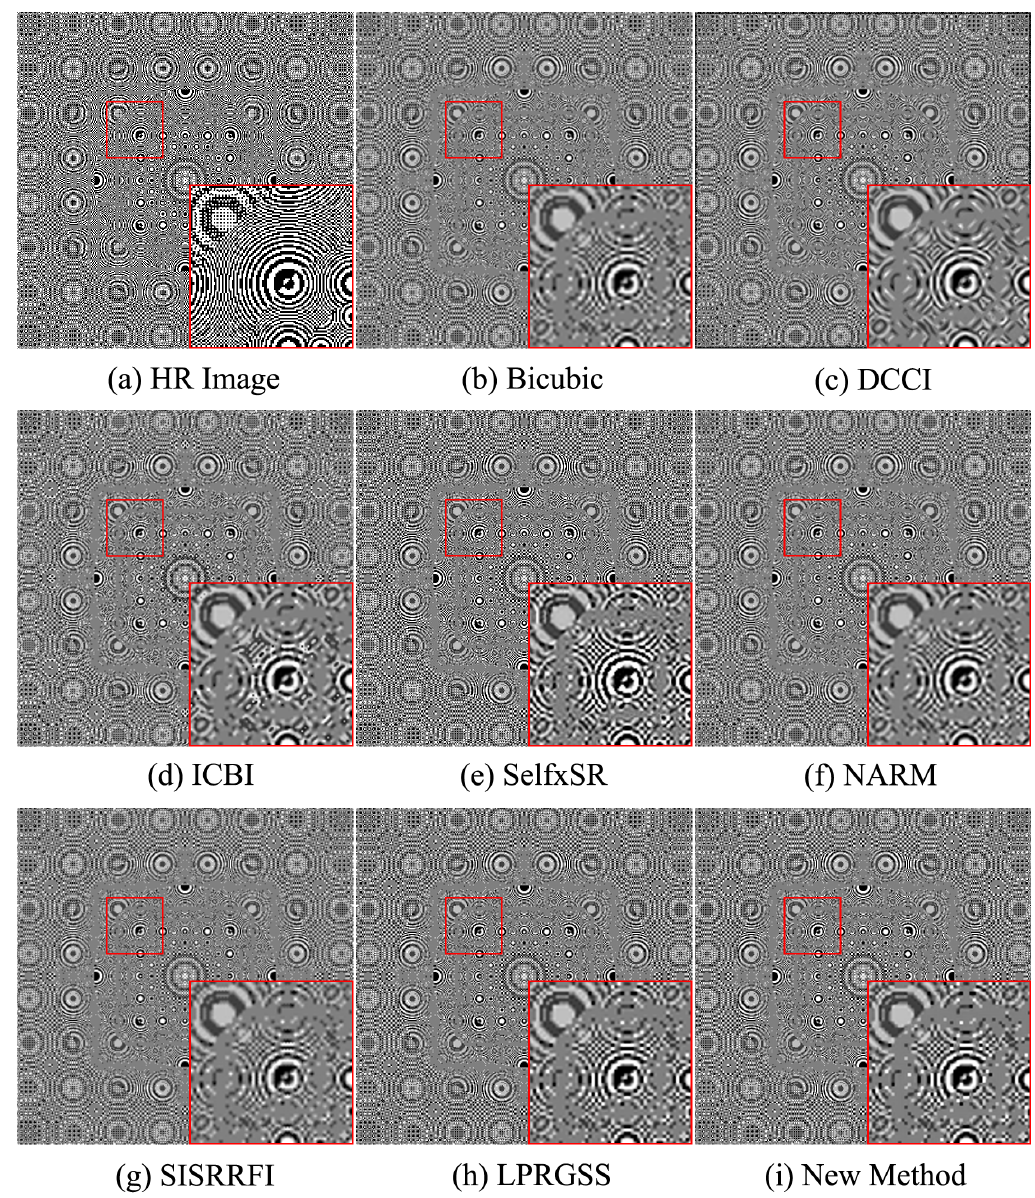
Figure 8. Aliasing images magnified by eight methods.